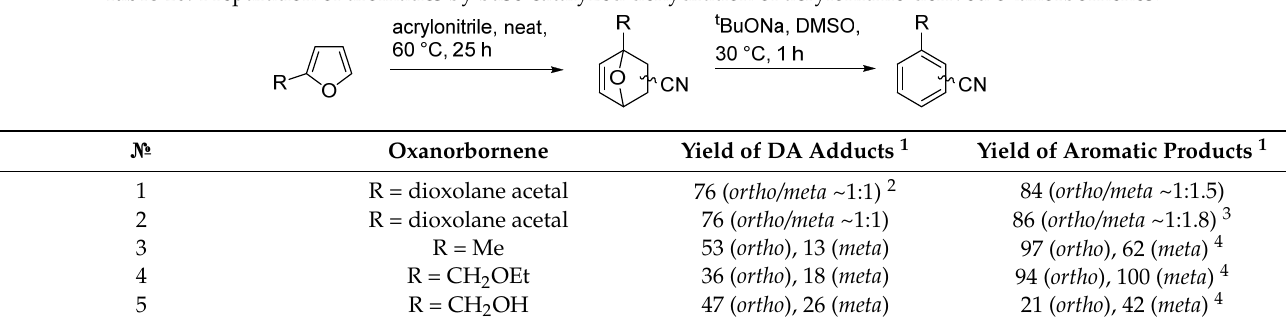
Table 10. Preparation of aromatics by base-catalyzed dehydration of acrylonitrile-derived oxanorbornenes.